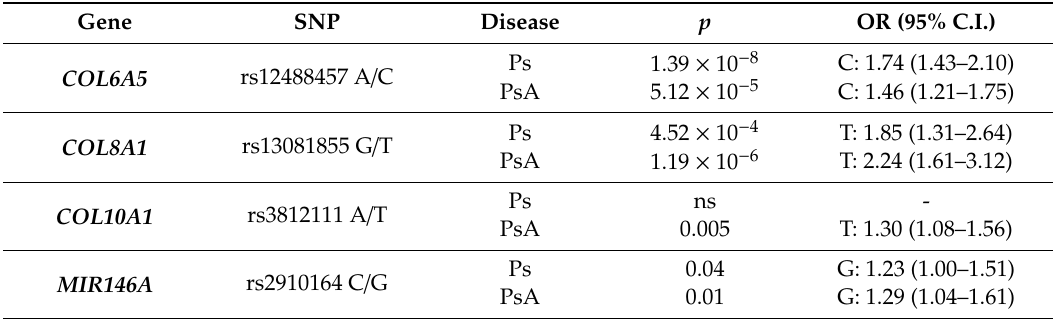
Table 2. Biostatistical results obtained by the genotyping analysis on patients with Ps, PsA and healthy control subjects. ns: not significant.